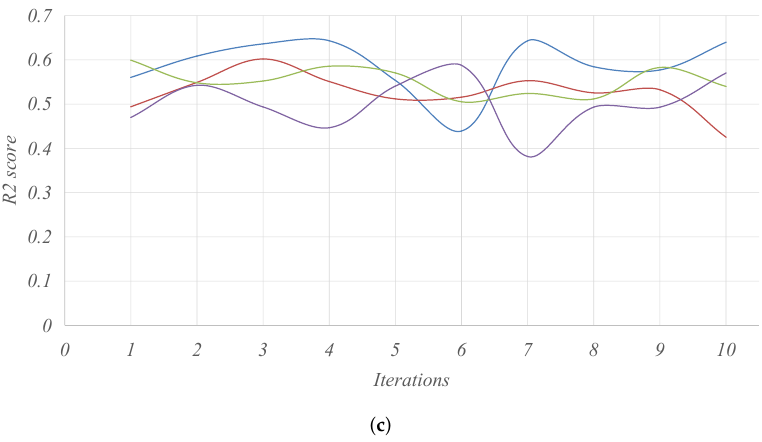
Figure 4. Shijiazhuang PM2.5 prediction scores. ( a ) MSE score for testing data predictions; ( b ) MAE score for testing data predictions; ( c ) R 2 score for testing data